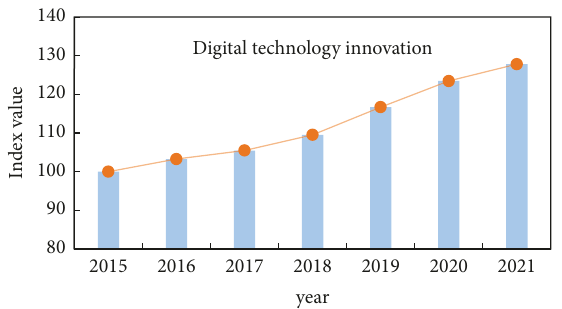
Figure 6: Digital technology innovation evaluation results.